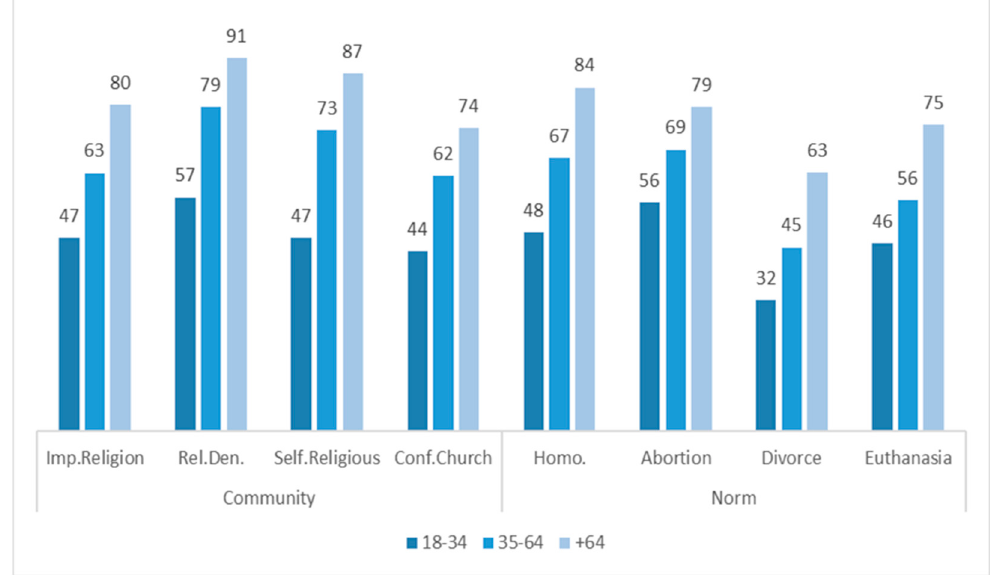
Figure 1 . Community and norm variables by age group in Portugal in 2020 (%) . Source: EVS (2021) .